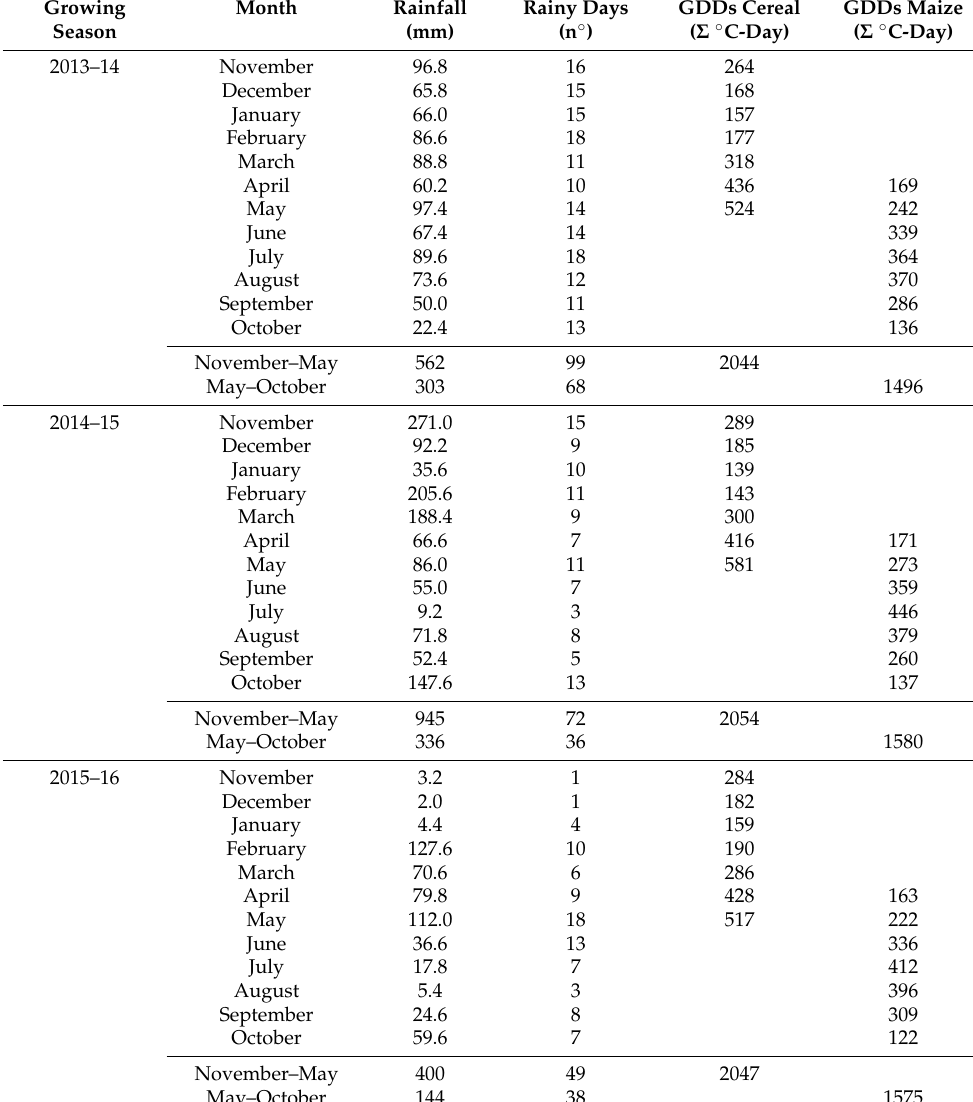
Table 3. Total rainfall, rainy days and growing degree days (GDDs) 1 in the three growing seasons. Growing Month